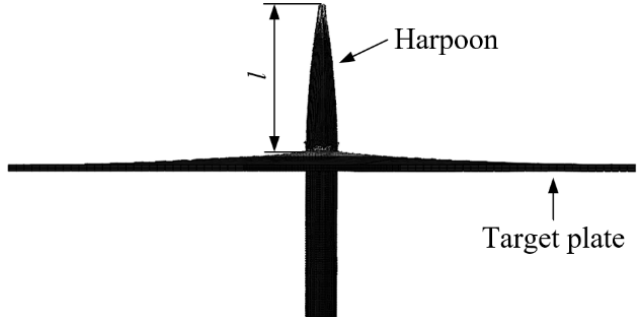
Figure 5. Maximum embedding length of harpoon.